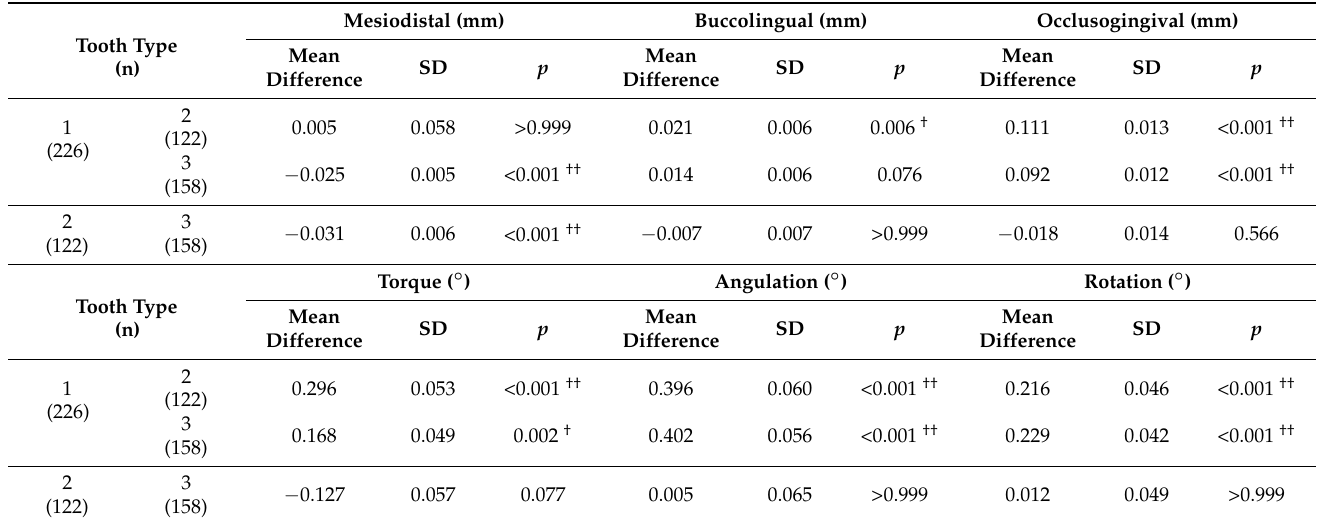
Table 5. Mutual comparison between six anterior teeth, premolars, and molars (group B).